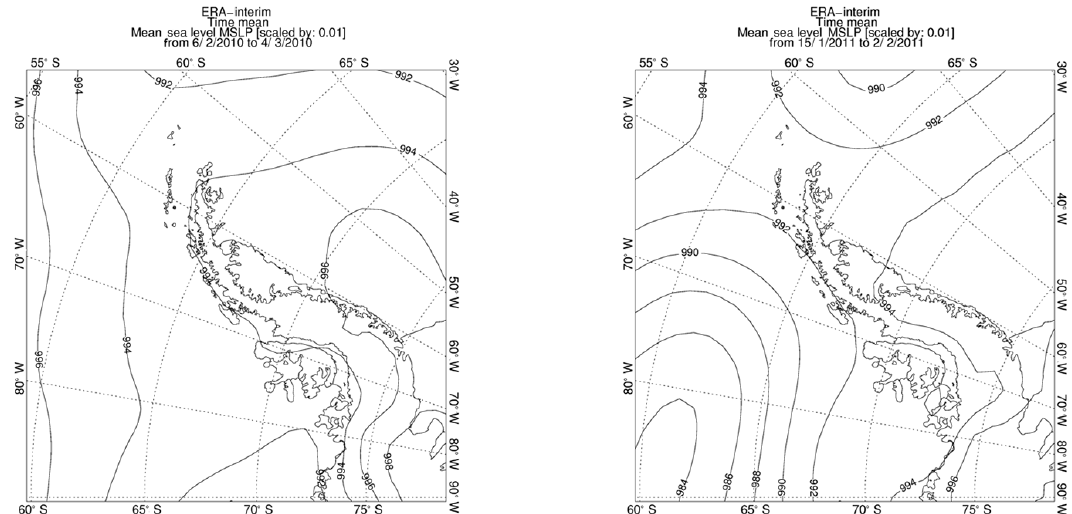
Figure 3. Mean sea level pressure from the ERA-Interim reanalysis for the periods of the aircraft campaign in 2010 (left) and 2011 (right).